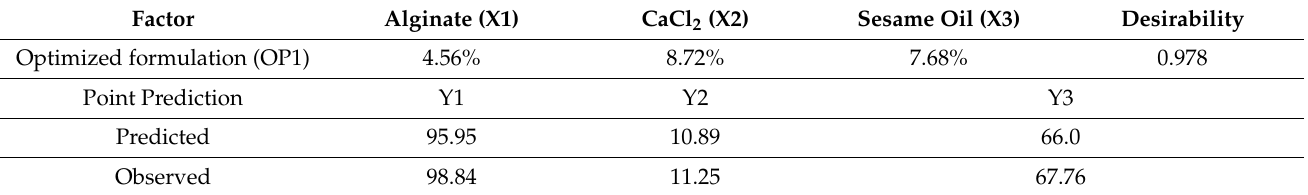
Table 4. The composition and observed and predicted values of the optimized formulation based on desirability using the central composite design.